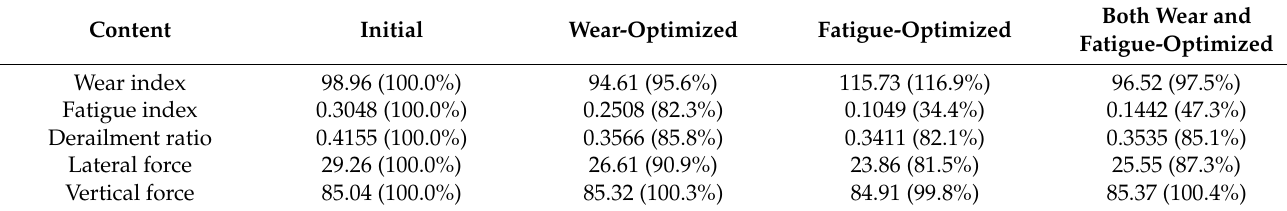
Figure 16. Lateral displacement of wheelset. Table 3. Comparison of performance